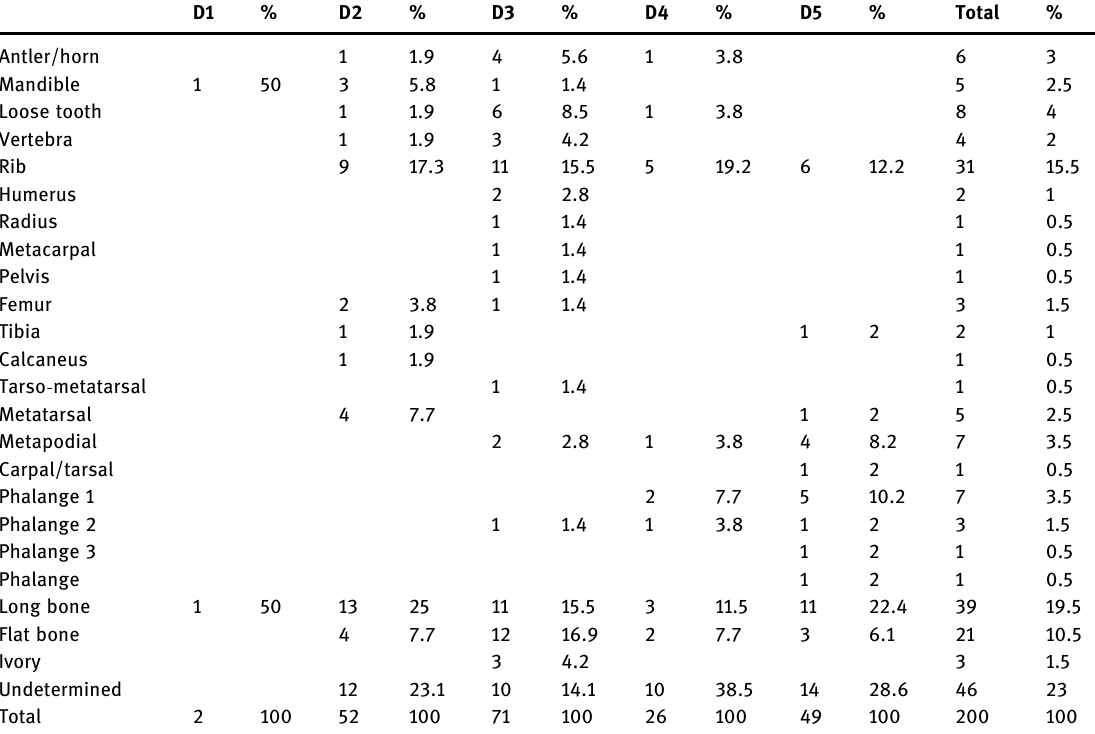
Table 6: Absolute and relative values on the presence of burning damage according to element and degree ( D ) of damage for pit 16 D1 %